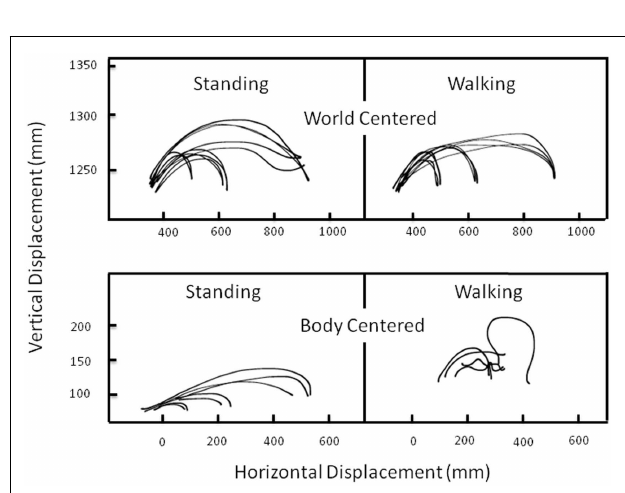
FIGURE 10 | Mean observed proportion of trials in which participants stood on the right foot when they grasped a plunger to move it far to the left, near to the left, near to the right, or far from the right, plotted as a function of the distance from the table at the start of each trial . From van derWel and Rosenbaum (2007).